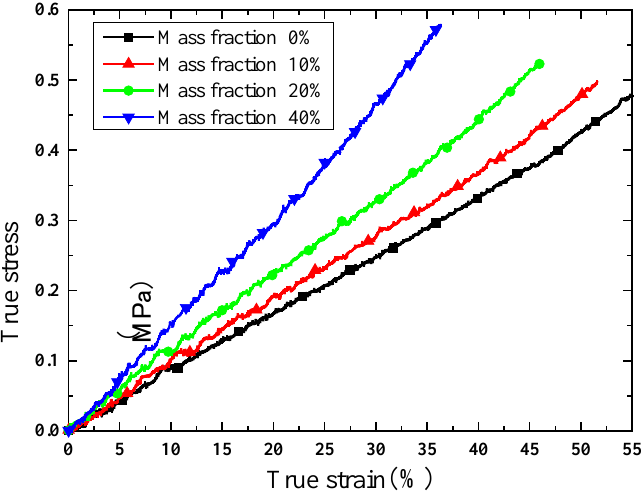
Figure 8. True strain versus stress curves at different mass fractions of phosphor with a strain rate of 8 × 10 −4 s −1 and no aging.